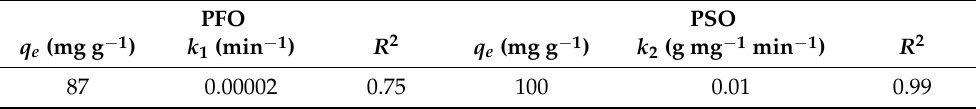
Figure 3. Kinetic modeling graphs of chromium adsorption on the walnut shell biochar: ( a ) PFO ( b ) PSO. Table 2. Kinetic model values for the walnut shell